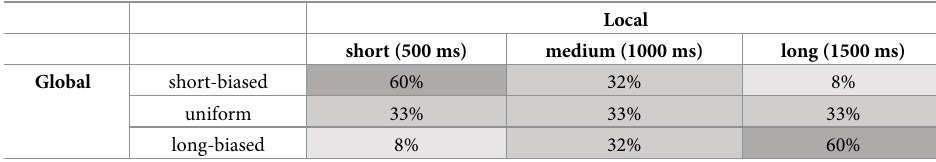
Table 3. Simple reaction time task